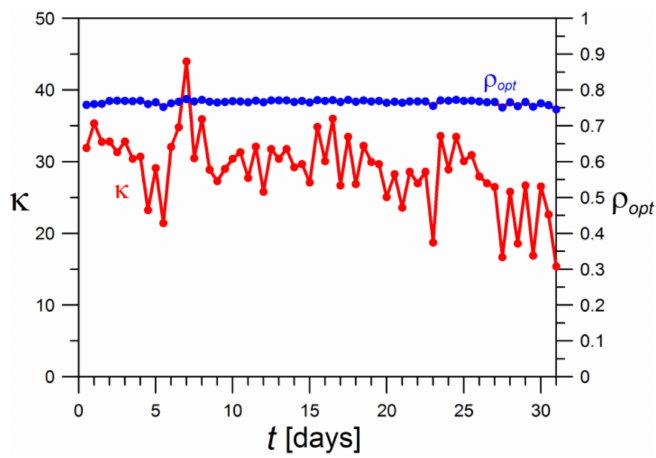
Figure 16. Calculated values of the pricing parameter κ and values of ρ opt